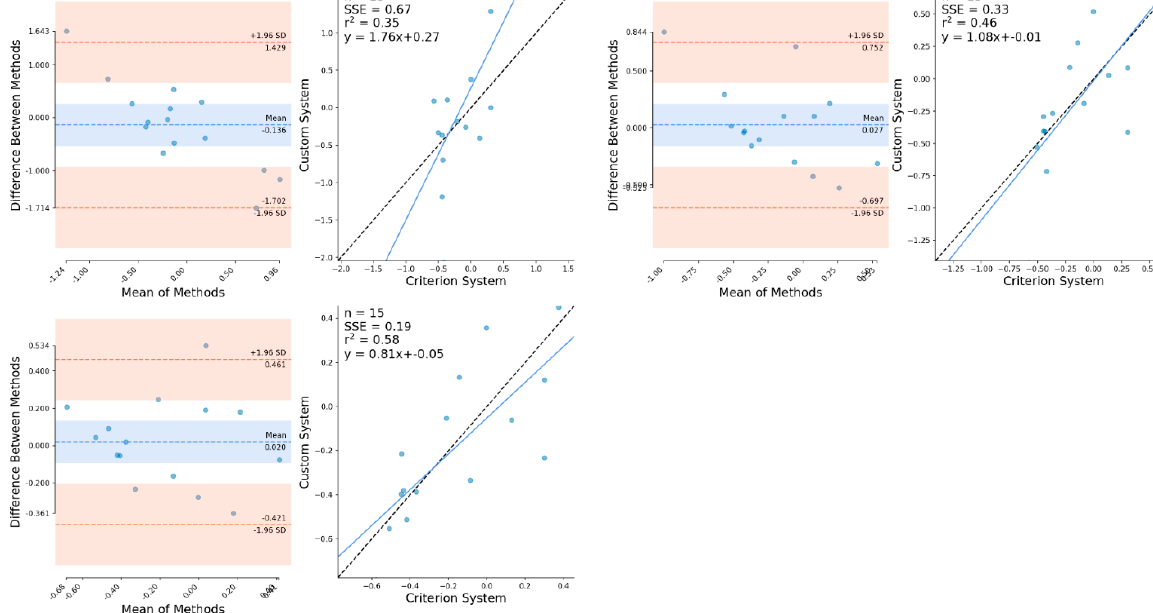
Figure A11. Bland-Altman and linear regression plots demonstrating the differences between OpenPose unfiltered (top-left), low-pass filtered (top-right) and Kalman smoothed (lower-left) CoM vertical velocity against marker-based CoM vertical velocity during pushing.